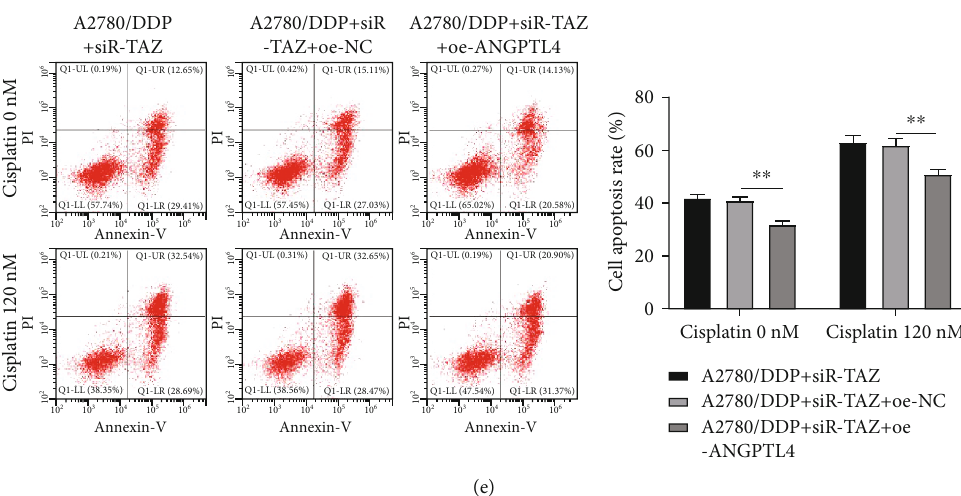
Figure 4: ANGPTL4 was a direct target gene of TAZ to regulate cell resistance. (a) ChIP-qPCR was used to verify the binding relationship of TAZ and ANGPTL4. (b) WB was adopted to detect the protein expression of ANGPTL4. (c) ELISA was used to determine the expression of ANGPTL4 in cell supernatant. (d) CCK-8 was employed to detect the drug sensitivity of drug-resistant EOC cells. (e) Flow cytometry was implemented to measure the apoptosis rate. Cell experiment was repeated three times. Data were expressed as mean ± SD , and one-way ANOVA analysis was employed for comparisons among groups. Tukey ’ s multiple comparisons test was used for the post hoc test. ∗ P < 0 : 05 , ∗∗ P < 0 : 01